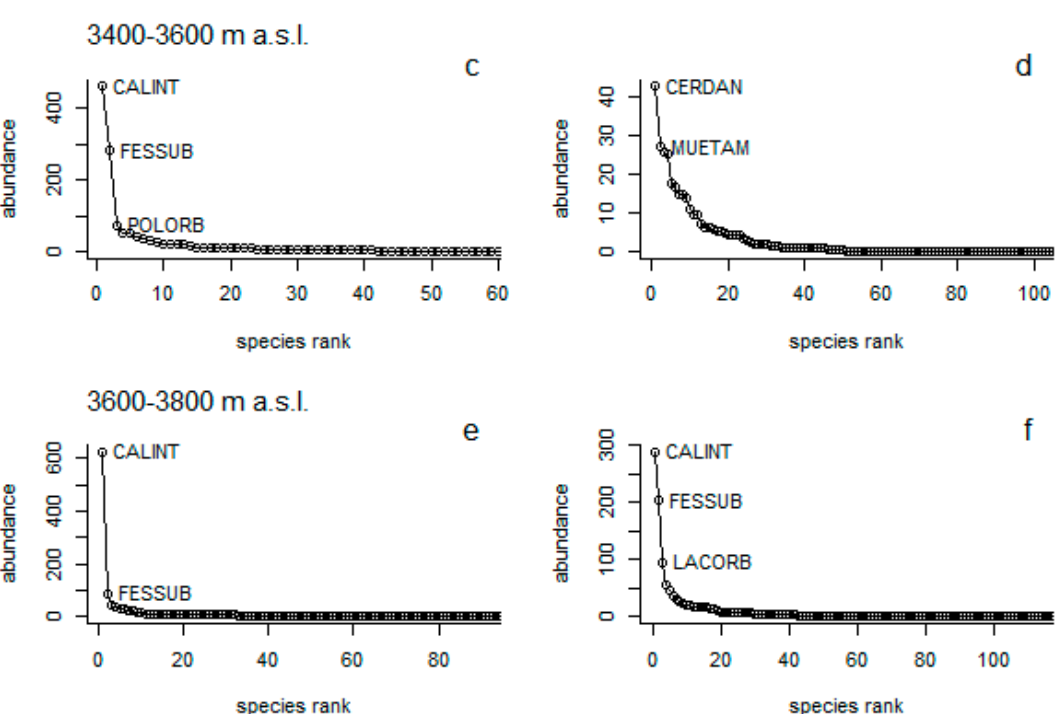
Figure 4. Herbaceous species abundance rank at natural grassland (NG) cover ( a , c , e ) and pine plantations (Pi) cover ( b , d , f ) across three different elevational gradients (3200–3400, 3400–3600, and 3600–3800 m a.s.l.).CALINT = Calamagrostis intermedia , AUSMAG = Austrolycopodium magellanicum, PASBON = Paspalum bonplandianum, TRISTI = Triniochloa stipoides, PEPsp = Peperomia sp, PECsp = Pecluna sp, FESSUB = Festuca subulifoli , POLORB = Polystichum orbiculatum, CERDAN = Cerastium danguyi, MUETAM = Muehlenbeckia tamnifolia, LACORB = Lachemilla orbiculate.